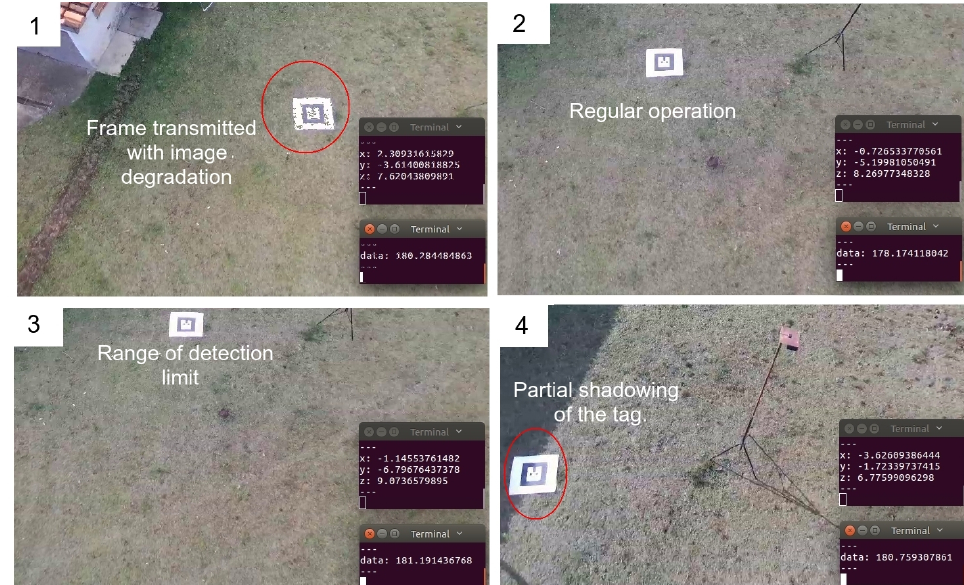
Figure 8. Figure showing snapshots of a flight round of the Bebop drone capturing the AR-Tag positioning. ( 1 ) Image frame transmitted with error, causing lost of accuracy; ( 2 ) Regular operation; ( 3 ) Tag near of detection limit; ( 4 ) Partial shadowing of the tag, causing lost of accuracy;